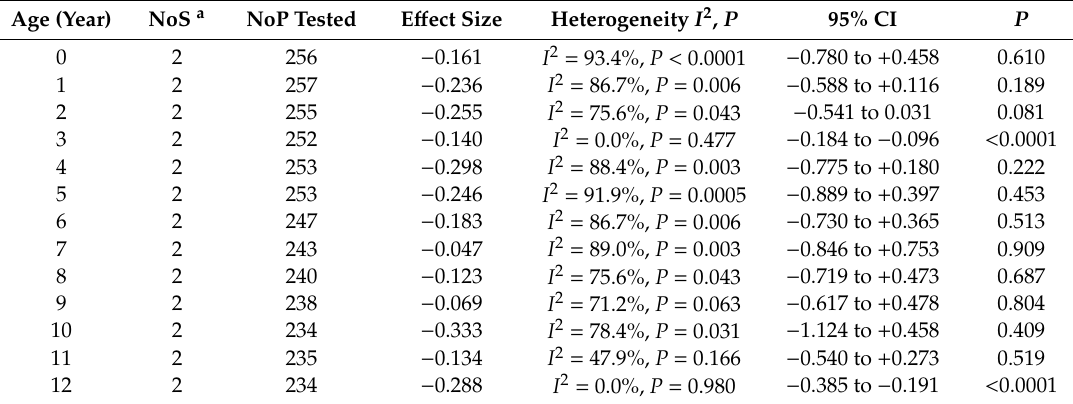
Table 7. Meta-analyses of height-for-age z-scores in children with mild hyperphenylalaninemia.